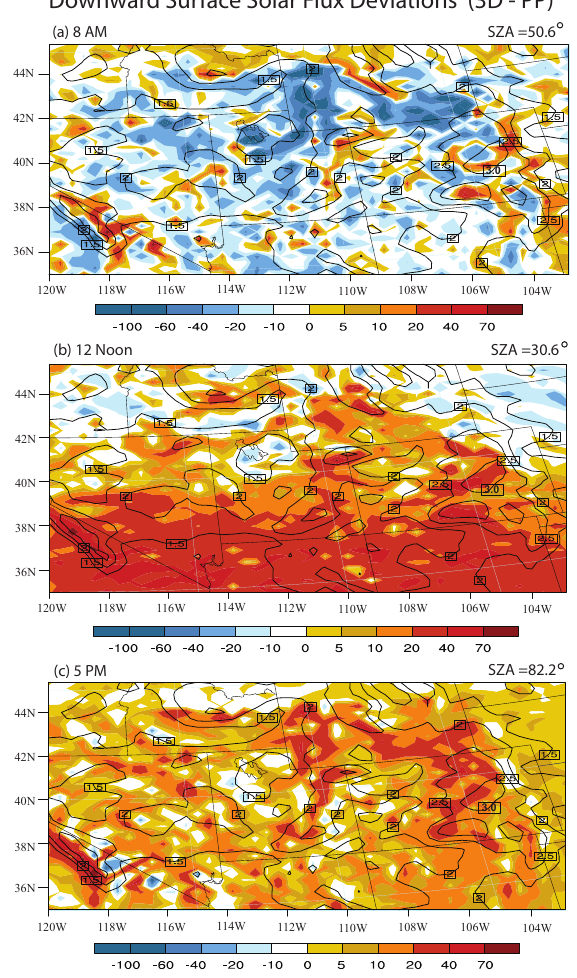
Downward Surface Solar Flux Deviations (3D - PP)